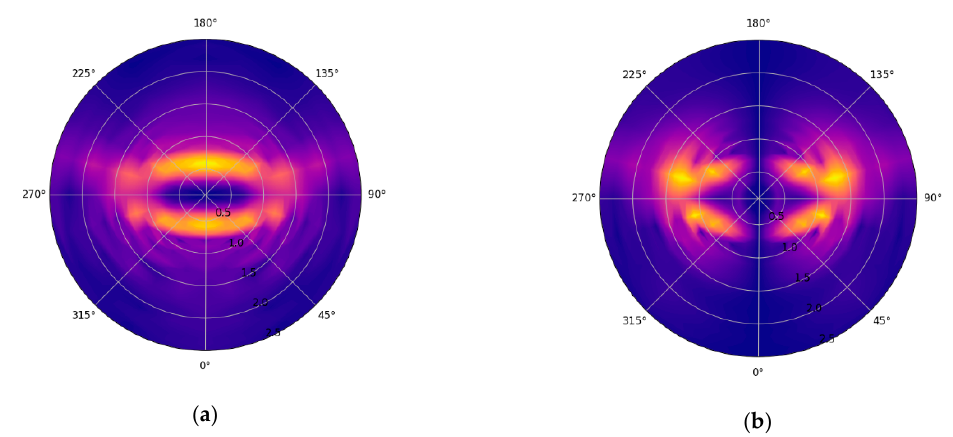
Figure 8. Bending moments at midship. ( a ) Vertical bending moment ( b ) Horizontal bending moment.